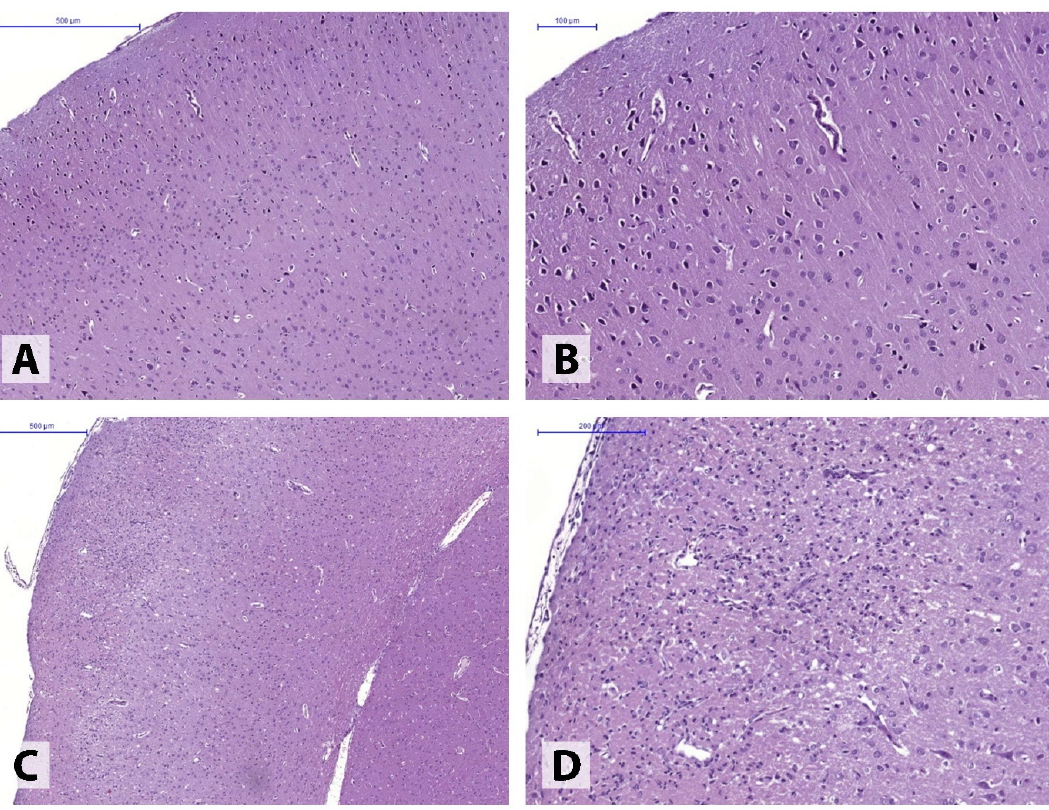
Figure 2. Minimal ( A , B ) and severe ( C , D ) pathological alterations in the somatosensory cortex following 30-min ipsilateral ischemia. Haematoxylin and eosin stain. Neurol. Int. 2022 , 14, FOR PEER REVIEW Our study found that transient MCAO ‐ induced cerebral ischemia in rats affected the amplitude, spectral, and cross ‐ correlation parameters of BEA (Tables S1 and S2). The na ‐ ture and severity of the observed changes were dependent on ischemia duration as well as the time after ischemia induction. In one of the IS 45 rats, periodic epileptic activity (approximately every 12 s) in the FP1/C3 area of the non ‐ ischemic hemisphere was rec ‐ orded on post ‐ surgery day 7. Additionally, the rat developed periodic spike activity in the O1/O2 area, above the hippocampus (Figure 3). Recording fragments containing spikes or sharp waves were omitted from further analysis.